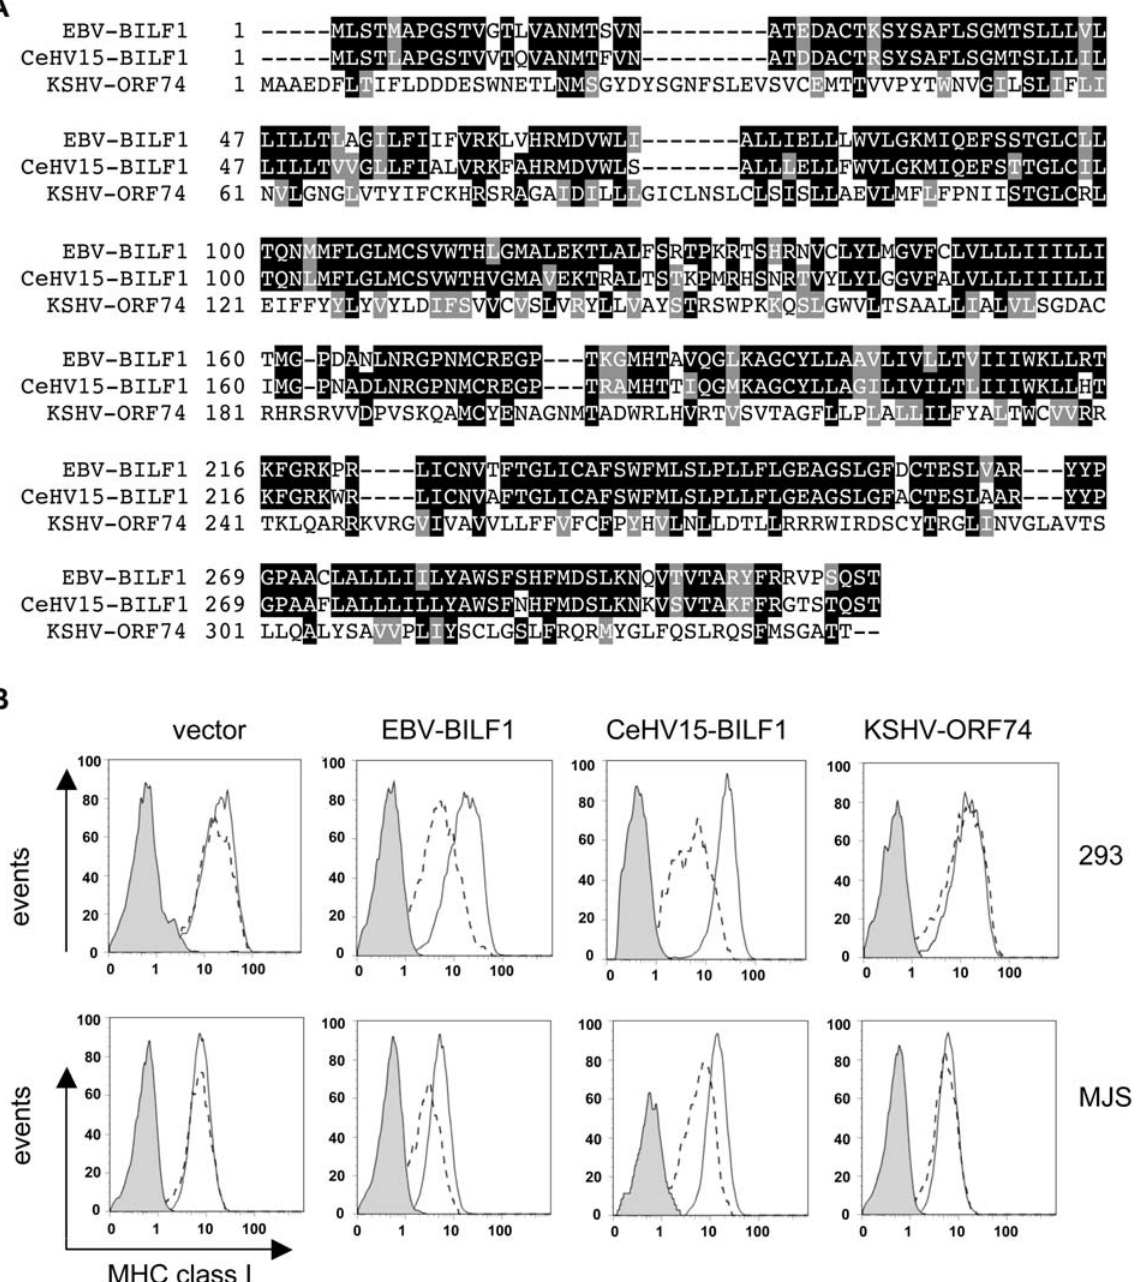
Figure 9. The ability of BILF1 homologs to downregulate MHC class I. ( A ) Multiple sequence alignment of EBV-BILF1, the rhesus lymphocryptovirus CeHV15-BILF1, and KSHV-ORF74. The alignment was done with ClustalW version 1.8, and shading was done with Boxshade version 3.21, available at http://www.ch.embnet.org/software/BOX_form.html. ( B ) 293 or MJS cells were transfected with EBV-BILF1, CeHV15-BILF1 or KSHV-ORF74 genes in the bicistronic vector, pCDNA3-IRES-nlsGFP. At 48 hr post-transfection, surface MHC class I molecules were stained and analyzed exactly as in Fig. 1.